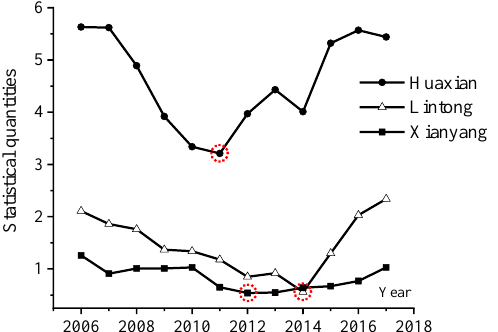
Figure 6. Fisher breakpoint detection of the average elevation of the main channel in the lower Weihe section in 2006 – 2018: The circle part is the lowest point.